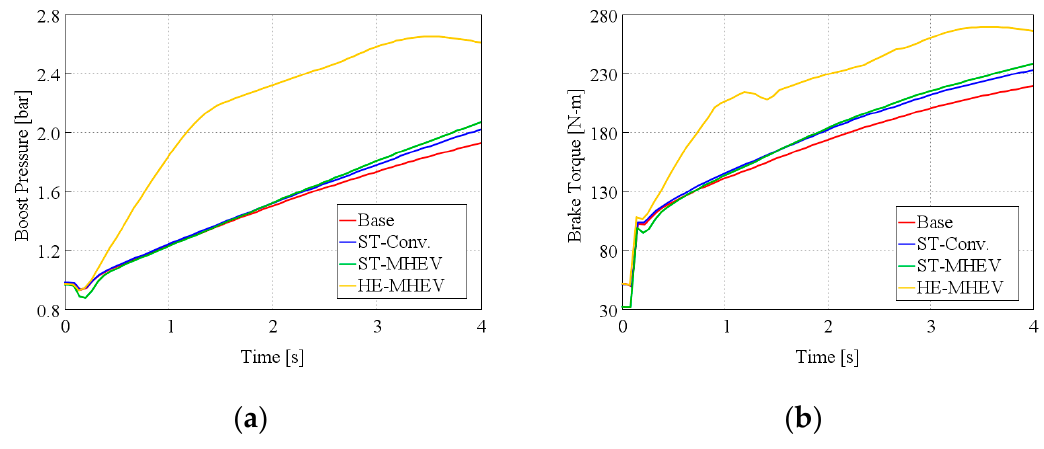
Figure 8. Detail of the 80–120 km/h in VI gear maneuver: ( a ) Boost Pressure; ( b ) Internal Combustion Engine (ICE) Brake Torque.